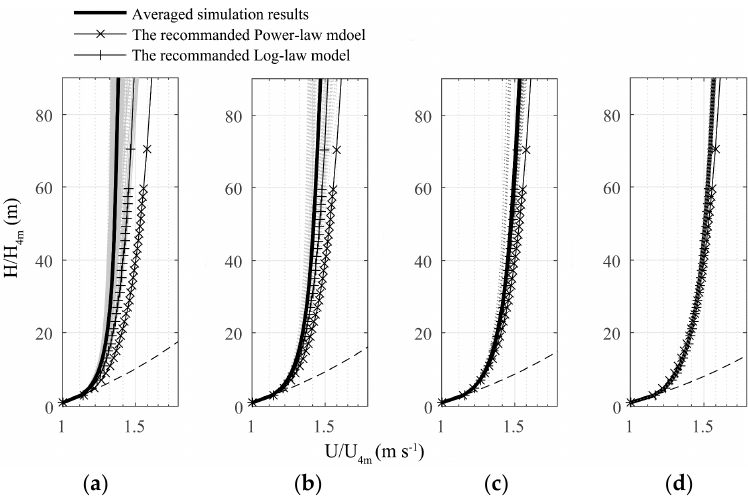
Figure 10. The comparisons between observed and simulated wind speed profile divided into 4 bins. The dashed line shows the slope of each mean wind speed profile at the 4 m-elevation: ( a ) 12–16 m · s − 1 ; ( b ) 16–20 m · s − 1 ; ( c ) 20–24 m · s − 1 ; and ( d ) 24–29 m · s − 1